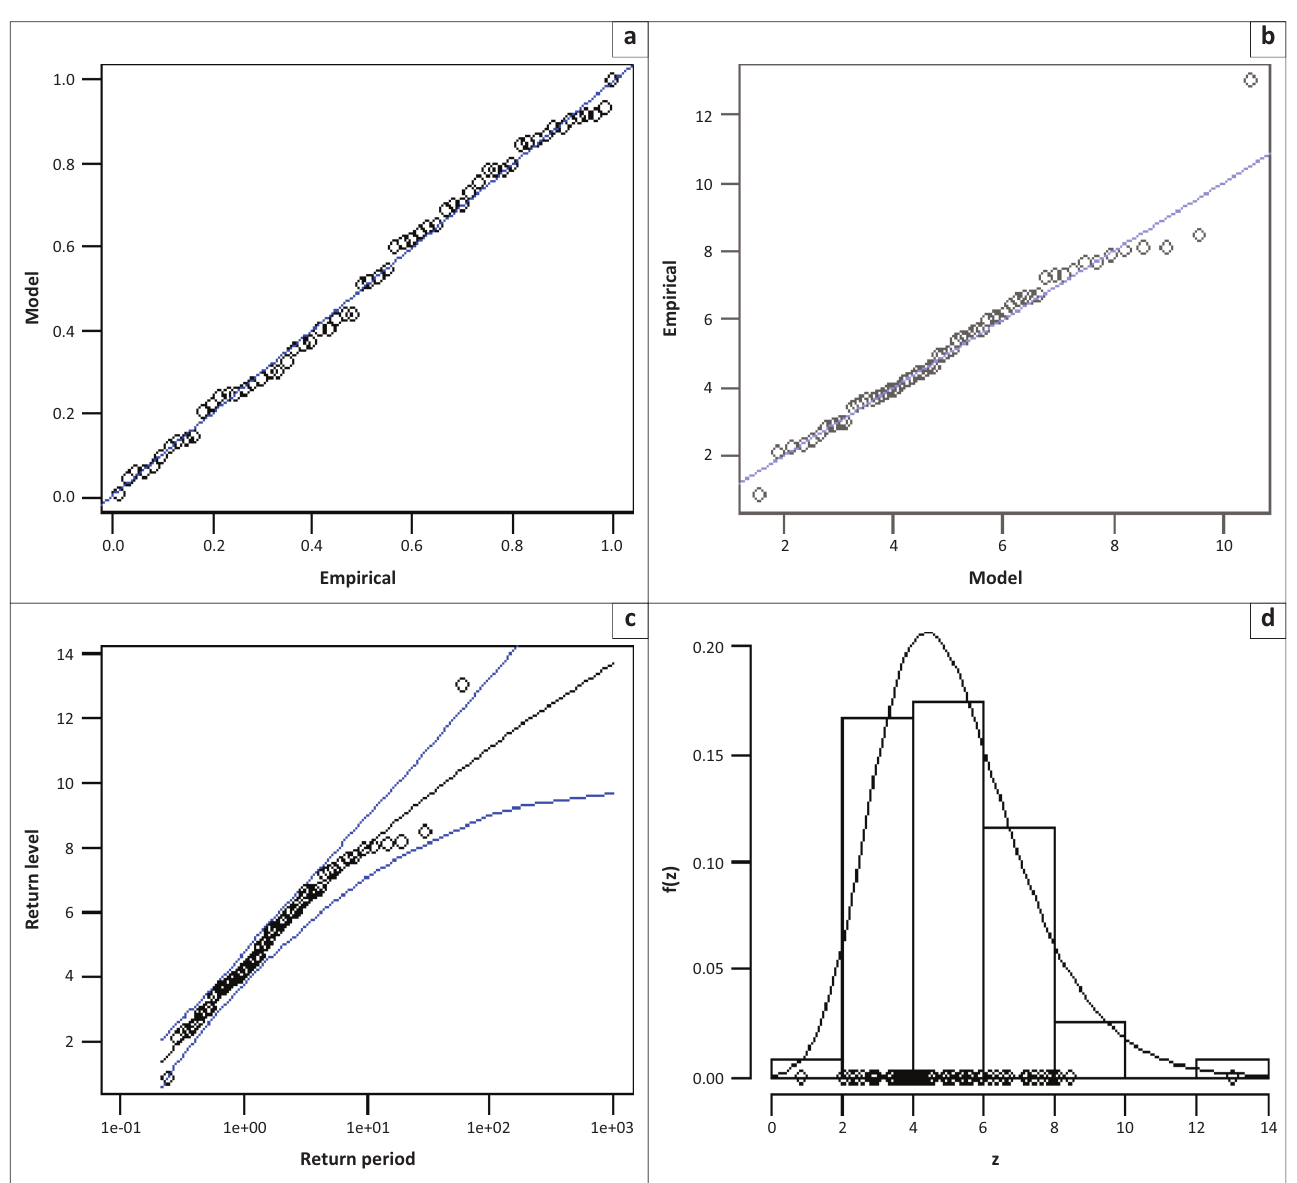
FIGURE 2: Diagnostic plots for the time-homogeneous generalised extreme value model at Chokwe hydrometric station: (a) Probability plot; (b) Quantile plot; (c) Return level plot; (d) Density